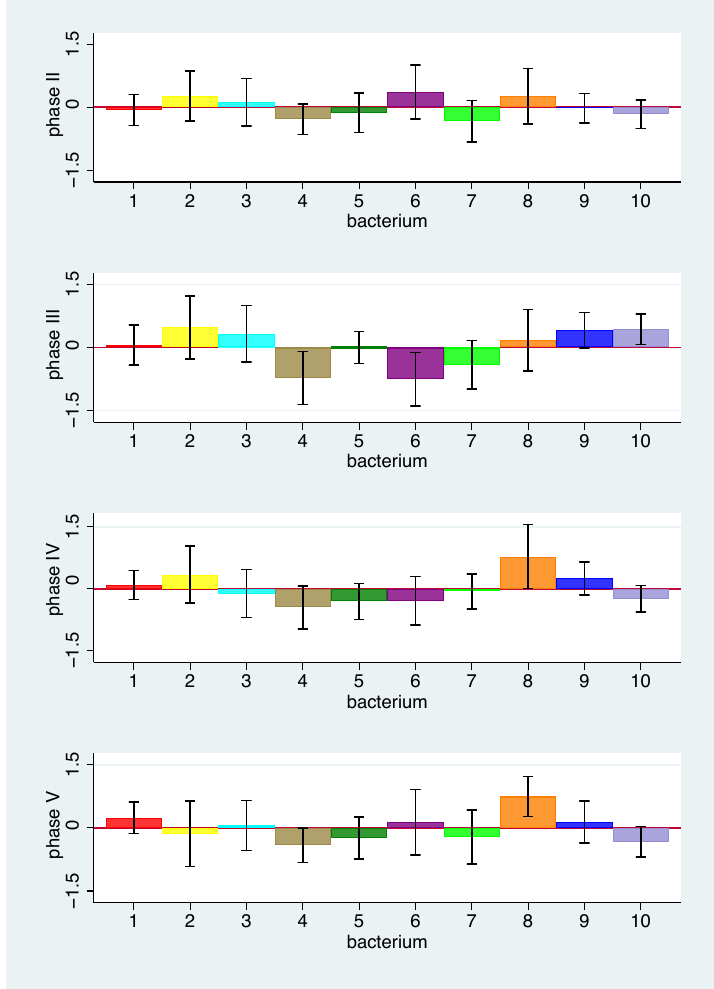
Figure 9. Mean values of average log ratio changes with 95% CI for bacterial groups 1 to 10 for phase II ( top ) to phase V ( bottom ). For colour scheme, see Figure